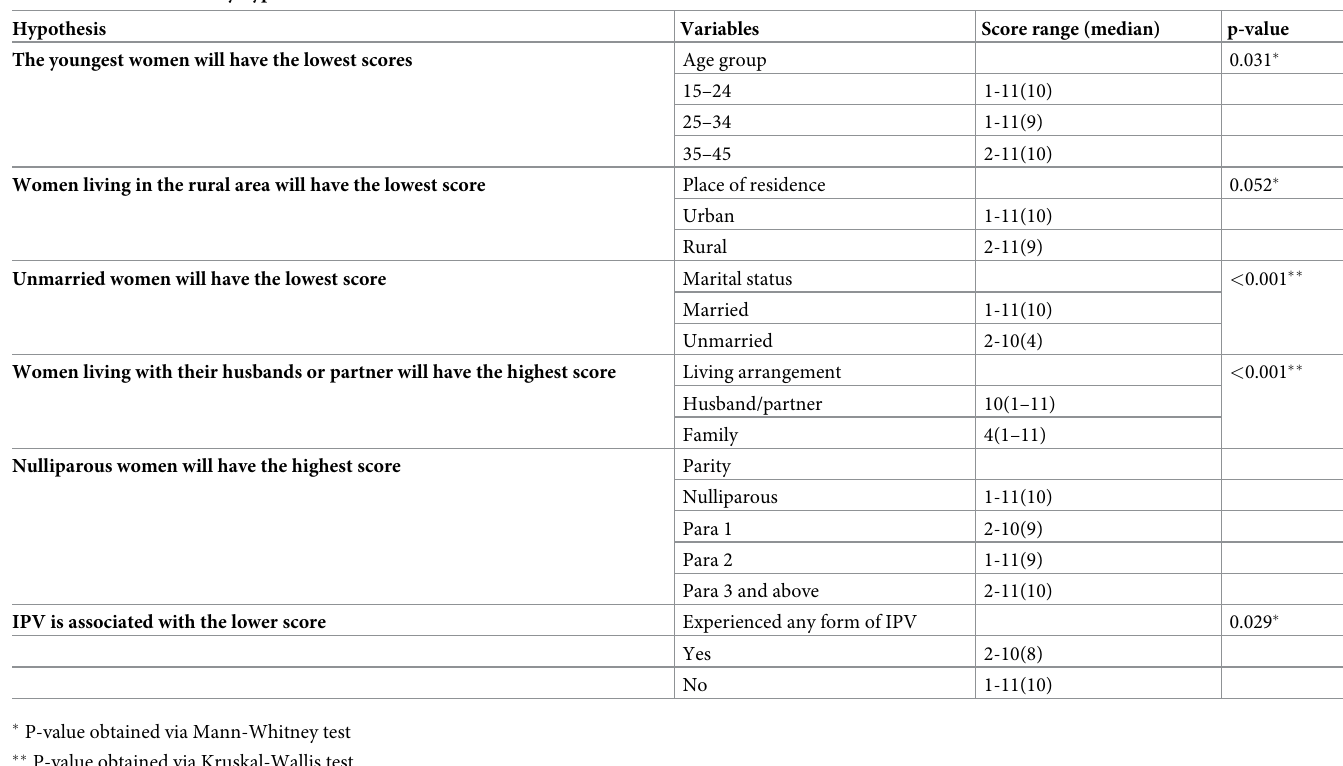
Fig 2. Scree plot of Eigenvalues for Amharic LMUP. https://doi.org/10.1371/journal.pone.0269781.g002 Table 9. Construct validity hypothesis